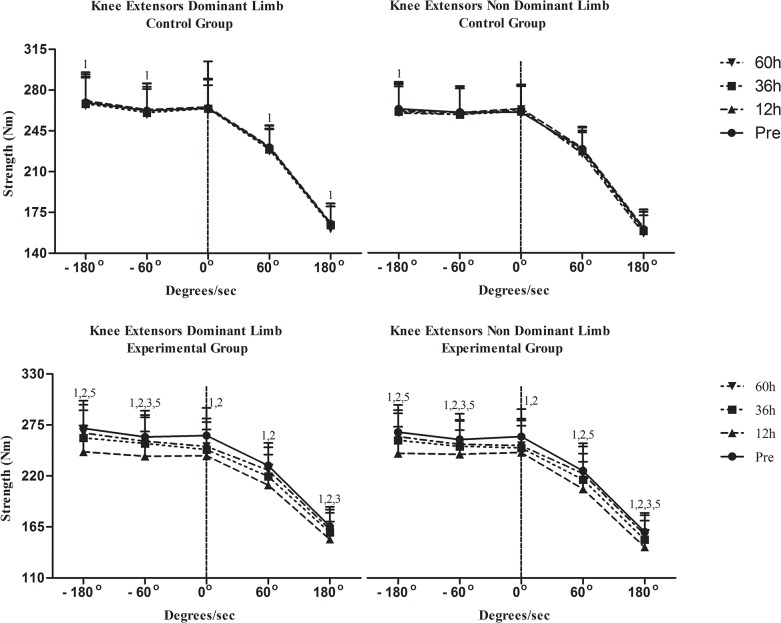
Changes of strength performance of knee extensors in response to a football match.h, hours; 1Significant difference with baseline; 2significant difference between groups; 3significant difference between dominant and non-dominant limb at corresponding time; 4greater decline in functional ration compared to conventional ratio at corresponding time;5greater decline at 180°/s compared to that at 60°/s at corresponding time.